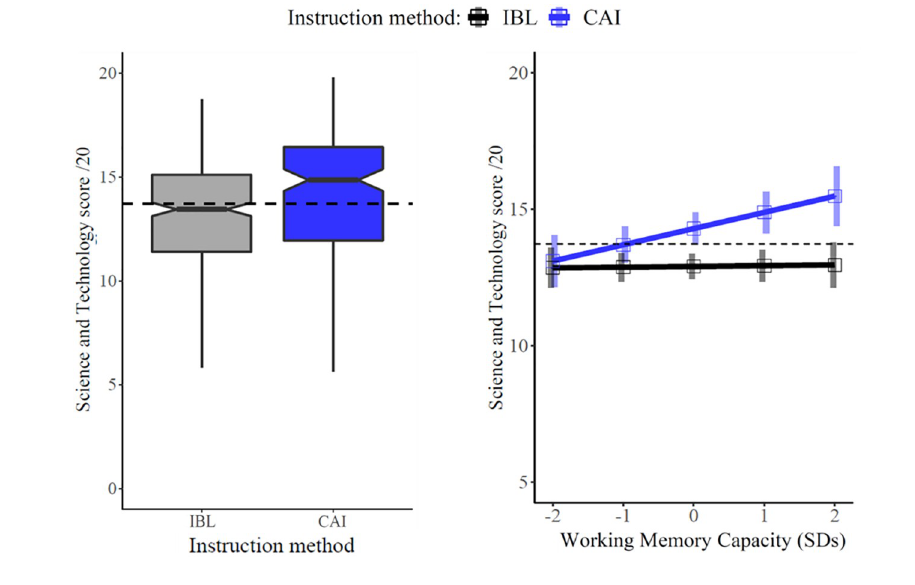
Fig 5. Adjusted mean Science and Technology scores (Model 4) in inquiry-based learning and computer-assisted instruction (left panel) and as a function of students’ working memory capacity (right panel).